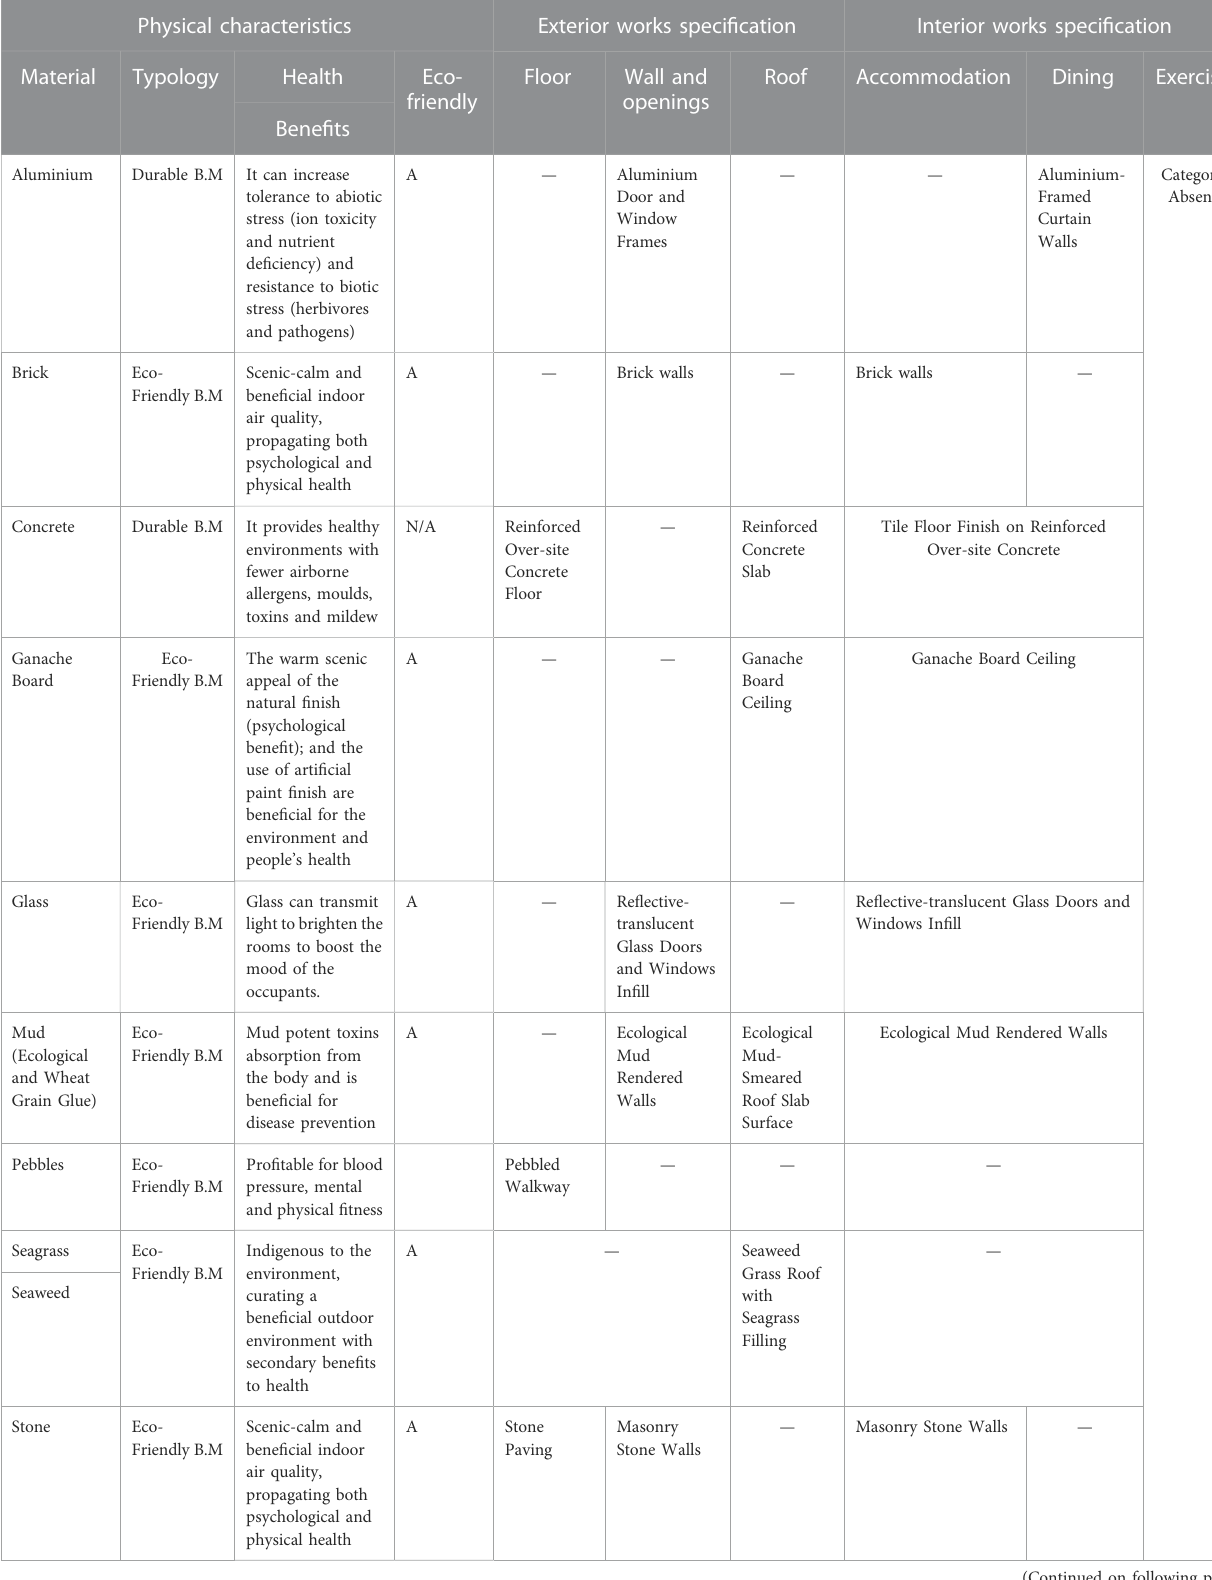
TABLE 4 Seaweed bay health resort (Weihai,